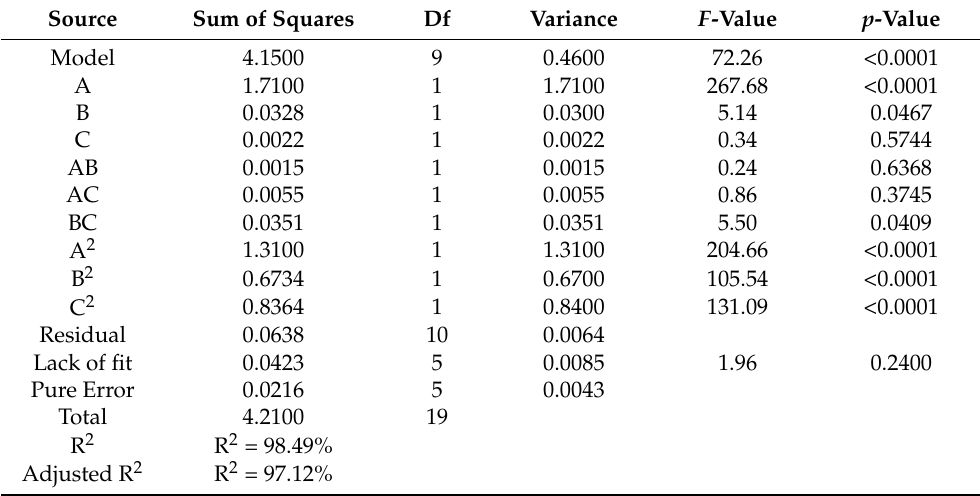
Table 4. Results of regression equation variance